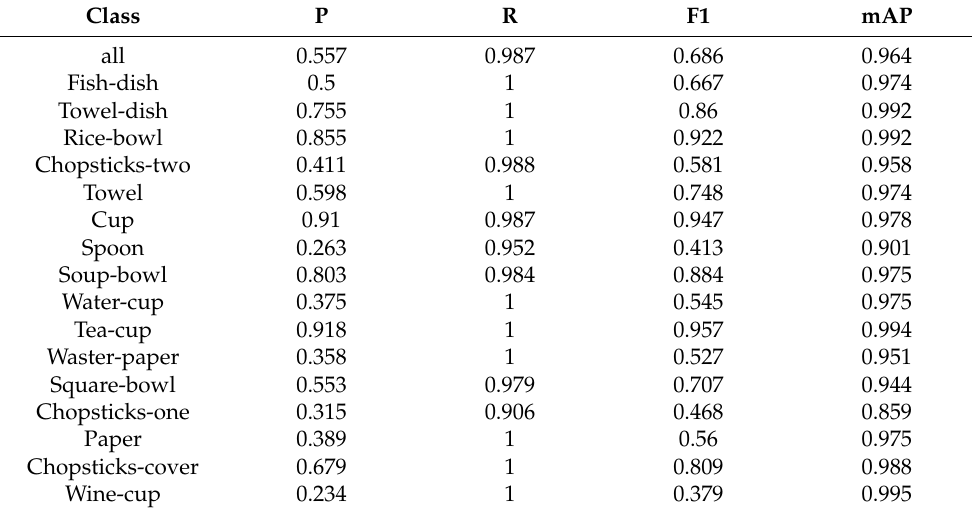
Table 1. Detection results of base